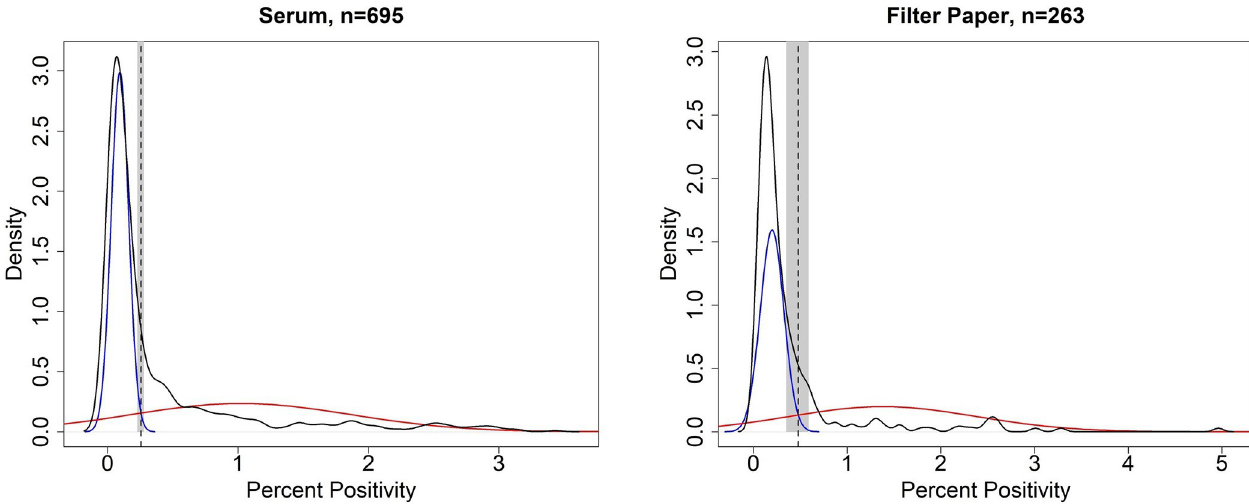
Fig 2. Mixture distribution model results. Mixture distribution models for ELISA results of serum and filter paper samples from free-ranging muskoxen tested against Erysipelothrix rhusiopathiae . Black curve: frequency distribution of the ELISA results (Percent Positivity) for the datasets (serum or filter paper samples). Blue and red curves: estimated underlying distributions of negative and positive samples, respectively. Dotted vertical lines: cut-off value obtained through mixture distribution analysis. Grey area: 95% Confidence Intervals (CI) computed through 1,000 bootstrap iterations. Optimal cut-offs were estimated at 0.25 (95% CI = 0.23–0.28) and 0.48 (95% CI = 0.35–0.59) for serum and filter paper samples,